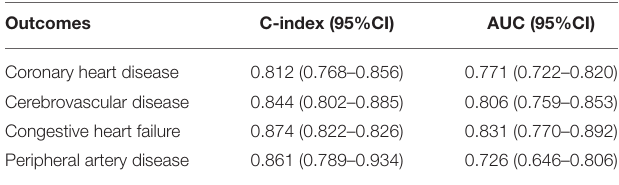
TABLE 4 | Subgroup analysis of the performance of different cardiovascular